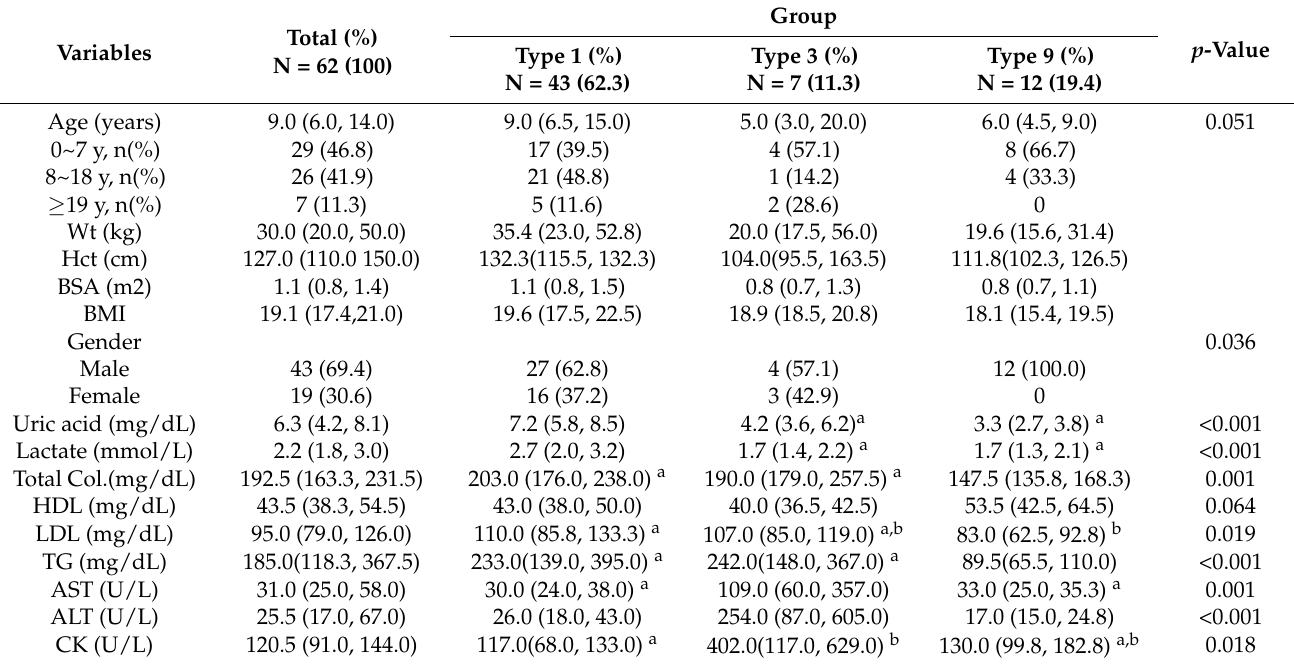
Table 1. Characteristics of the study